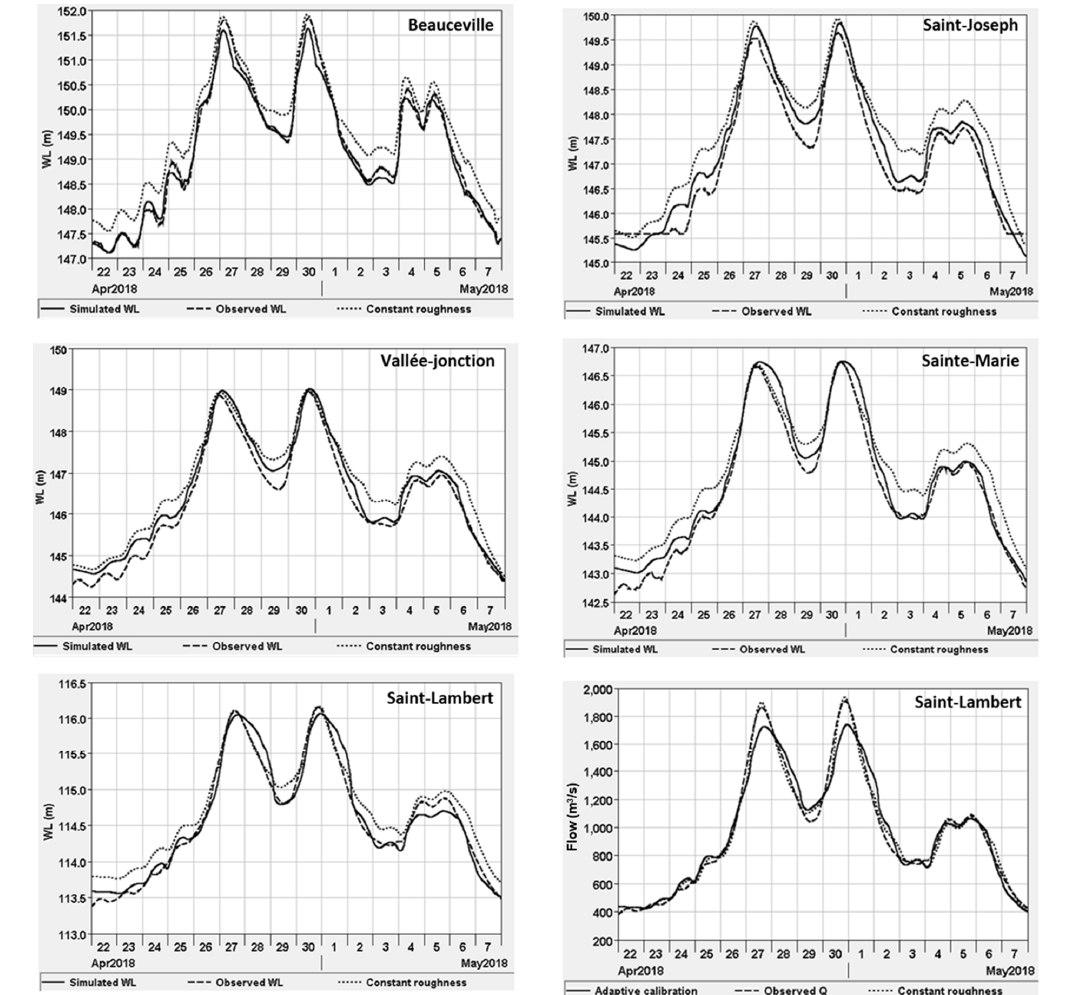
Figure A1. Water level series for adaptive flow-based calibration (solid line) vs. constant Manning calibration (dotted line) vs. observation (dashed line).